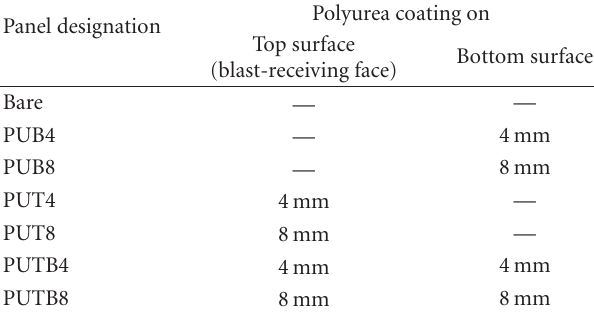
Table 1: Location of application of polyurea coating on each panel.